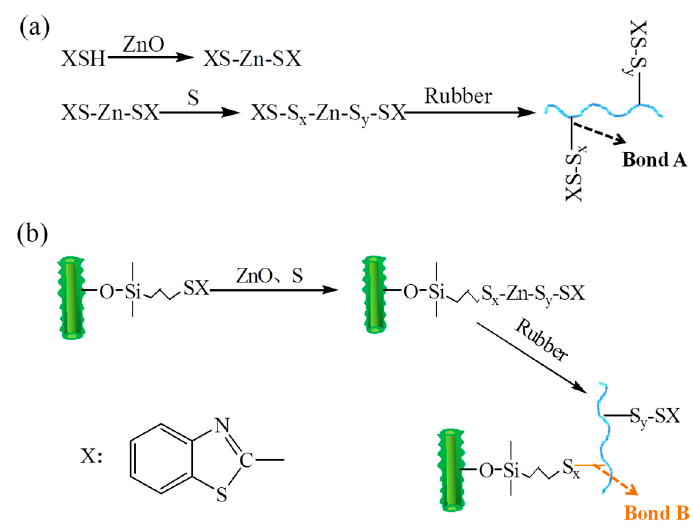
Figure 7. The possible vulcanization mechanisms of SBR compounds.